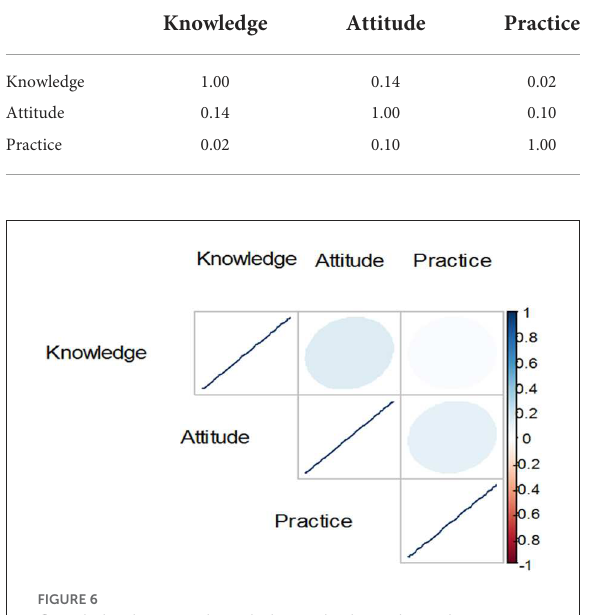
in private sector, studying and unemployed participants showed significantly decreased odds of high knowledge level by 33% (OR = 0.67, 95% CI: 0.53–0.85, p = 0.001), 24% (OR = 0.76, 95% CI: 0.62–0.95, p = 0.016), and 48% (OR = 0.52, 95% CI: 0.36–0.75, p = 0.001), respectively, when compared to participants working in government